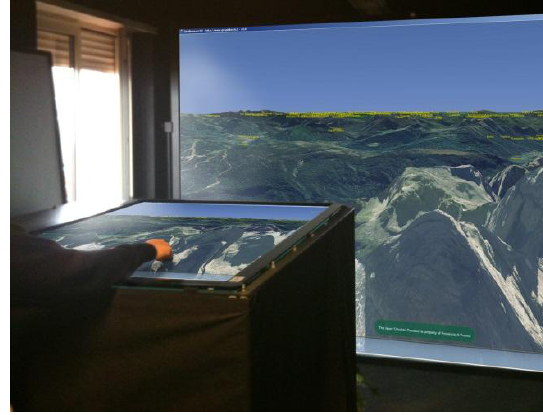
Figure 6: the multi-touch panel being used as further extension of the